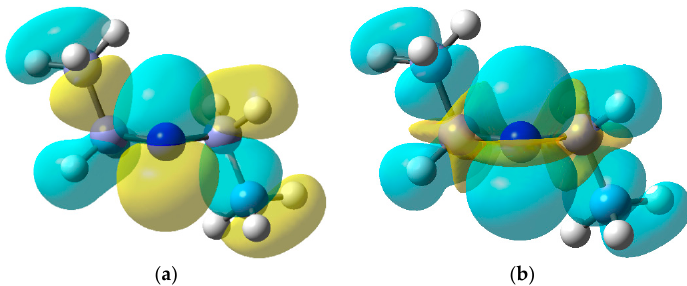
Figure 5. ( a ) DFT computed SOMO for diethylaminyl radicals; ( b ) Spin density distribution.